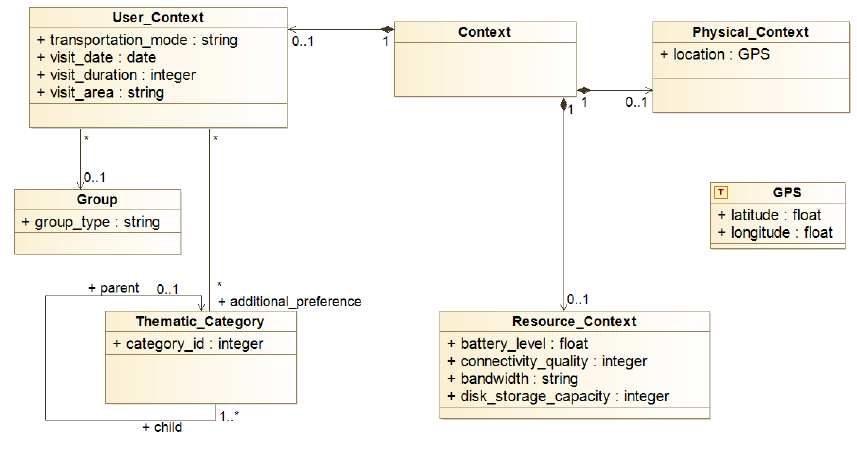
Figure 9. Context model.